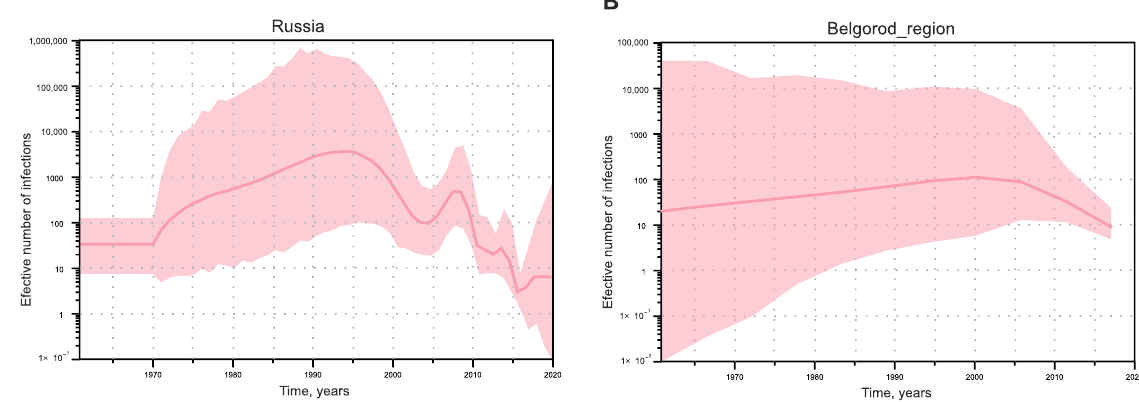
Figure 6. SkyGrid reconstruction for HEV-3 in Russia ( A ) and separately for Belgorod Region ( B ). The graphs show the relationship between the effective number of infections ( y -axis) and chronological time expressed in years ( x -axis). The red curve indicates the mean, with the 95% HPD interval shown in pink shading. Estimates were obtained using 101 sequences of the HEV-3 ORF-2 fragment (300 nt), including 41 sequences from Belgorod